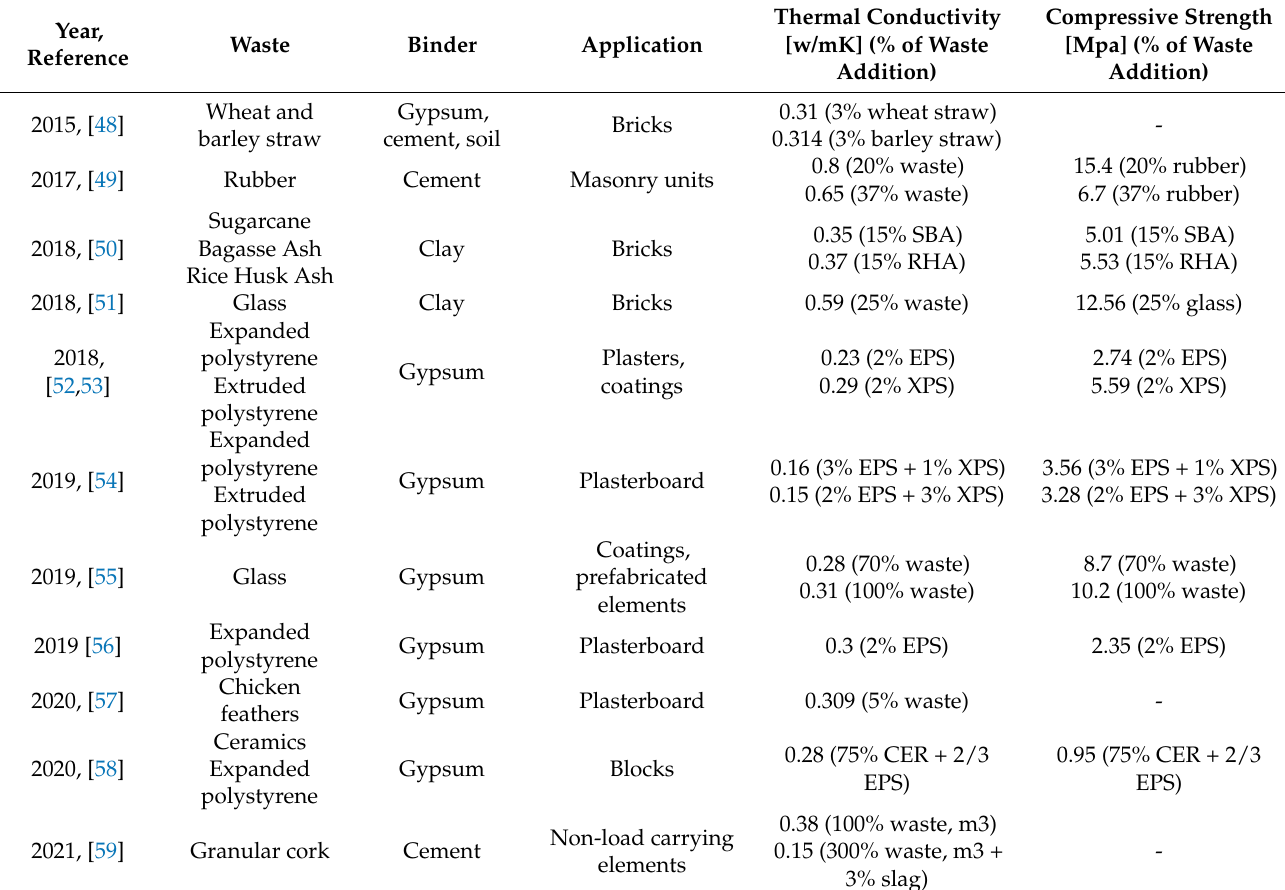
Table 1. Previous studies of recycled materials and their thermal